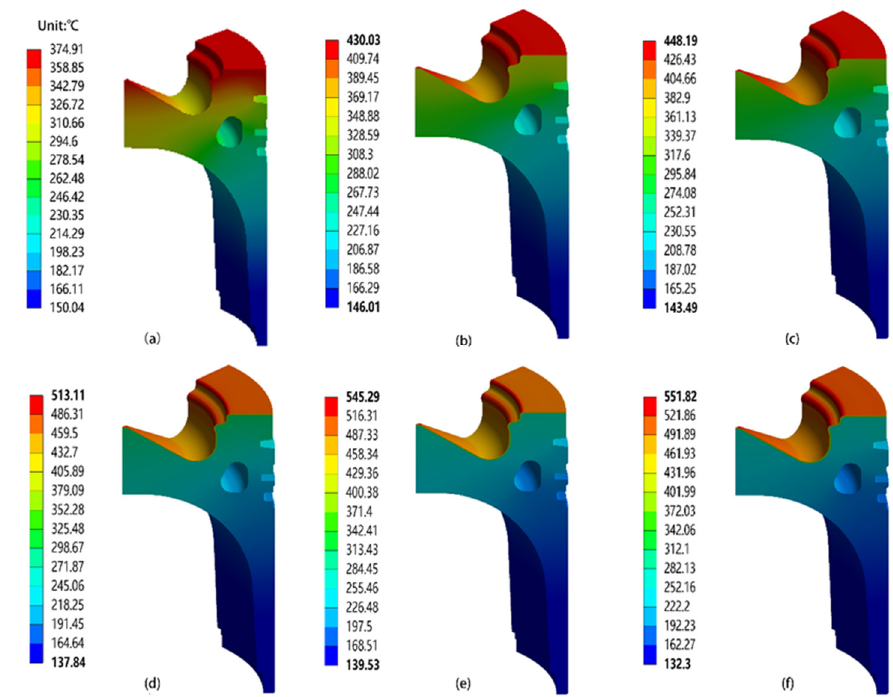
Figure 11. Temperature distributions of pistons coated using different thicknesses. ( a ) shows the temperature field of the uncoated piston, and ( b – f ) shows the overall temperature field of the piston with a total coating thickness of 0.3 mm, 0.4 mm, 0.6 mm, 0.8 mm and 1.0 mm.